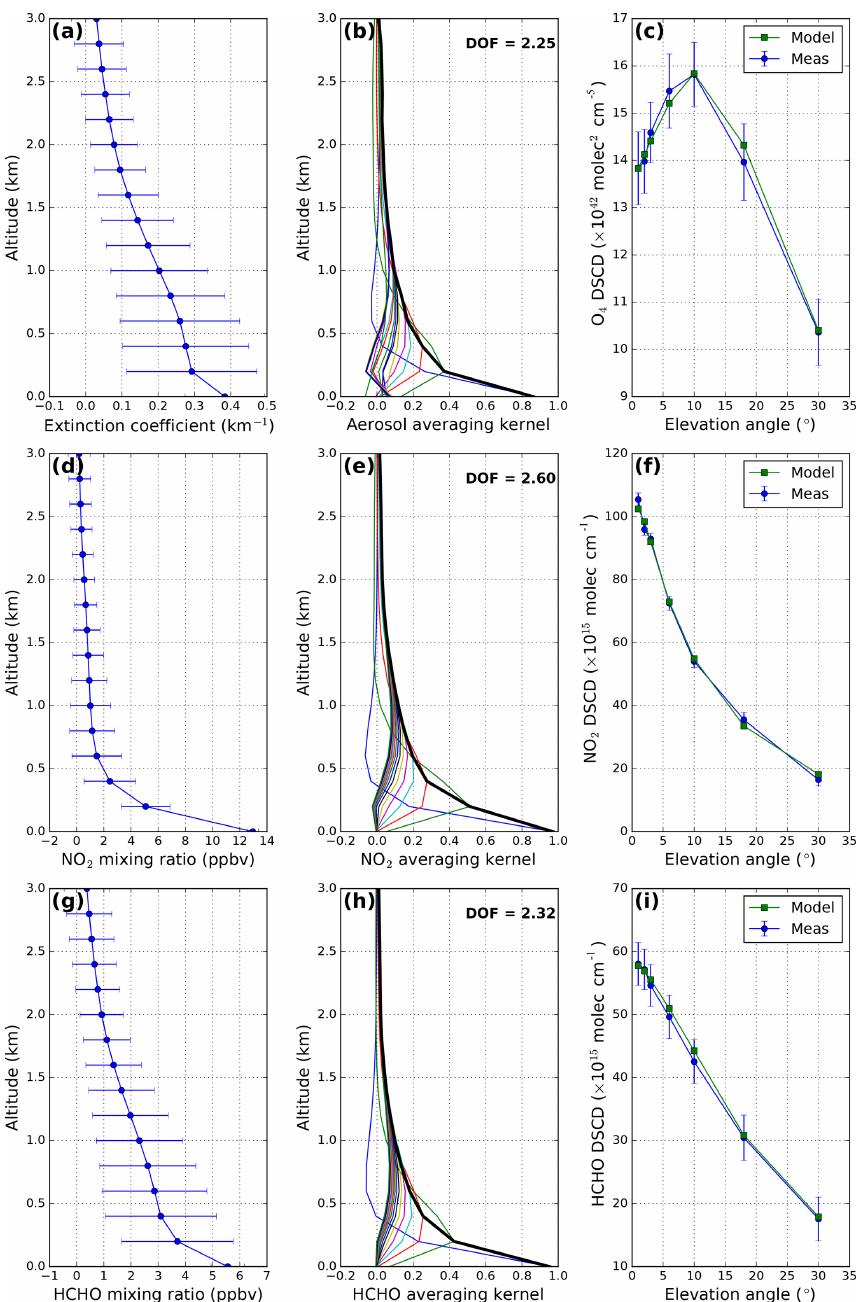
Figure 2. An example of vertical profile retrieval of aerosol extinction, NO 2 and HCHO from MAX-DOAS measurements taken on 4 July 2013 at around 08:47LT. The left panels show the (a) aerosol extinction, (d) NO 2 and (g) HCHO profiles. Panels in the middle column indicate the average kernel of (b) aerosol extinction, (e) NO 2 and (h) HCHO profile retrieval. The measured (blue curves) and modeled (green curves) DSCDs of (c) O 4 , (f) NO 2 and (i) HCHO are shown in the right